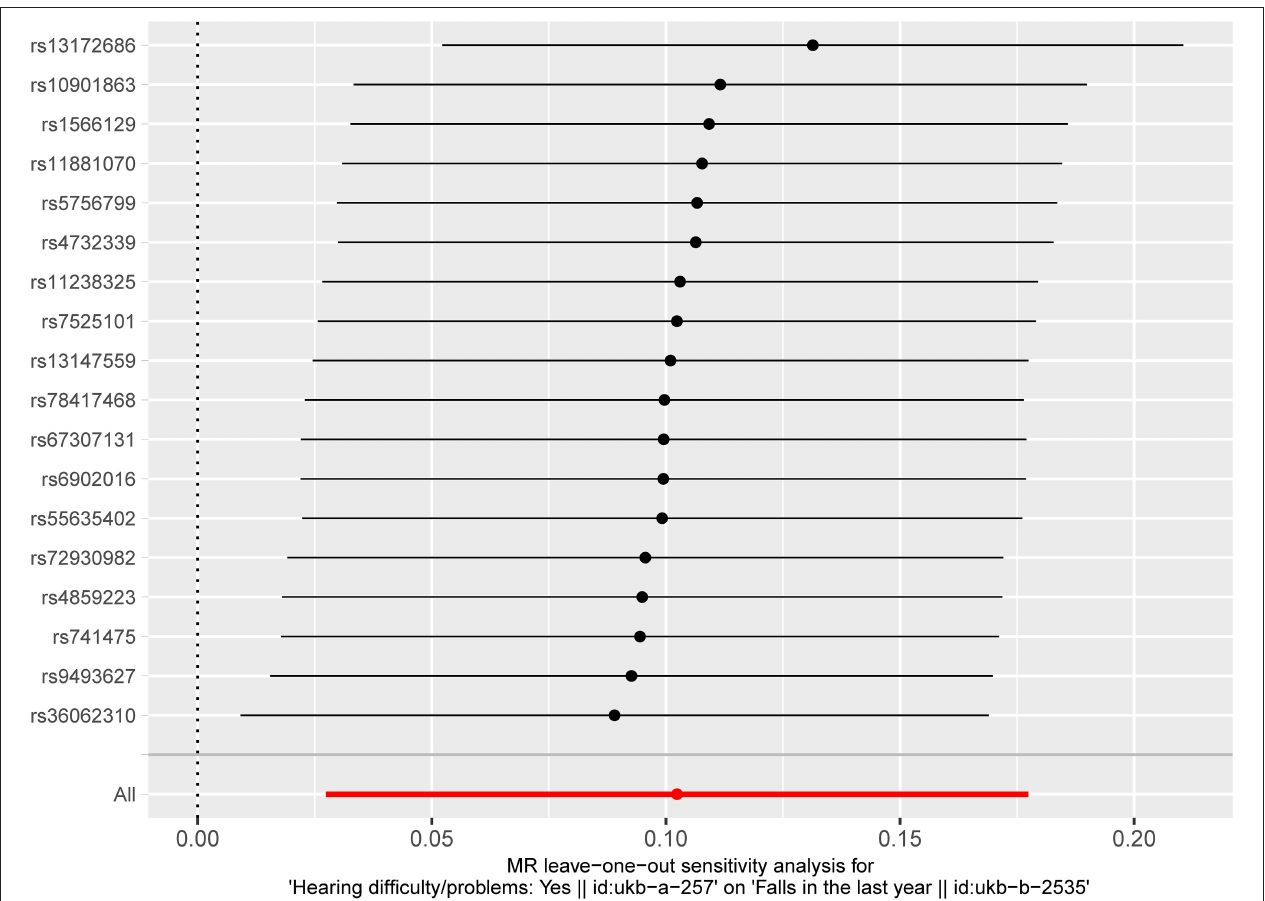
FIGURE 4 | “Leave-one-out” analysis of the causal association of HI with falls. The black dots and bars indicate the causal estimate and 95% CI when an SNP was removed in turn. The red dot and bar indicate the overall estimate and 95% CI using the fixed-effect IVW method. HI, hearing impairment; CI, confidence interval; SNP, single nucleotide polymorphism; IVW, inverse-variance weighted.